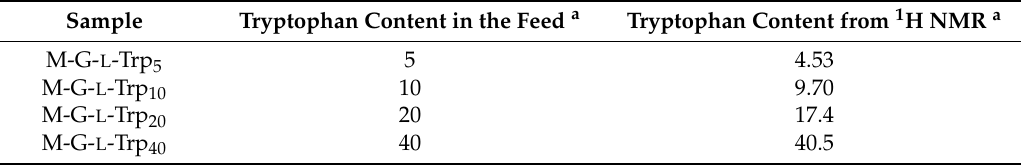
Figure 1. 1 H NMR spectrum of M-G- L -Trp 10 , recorded in D 2 O at 25 °C. Asterisks represent the signals of methylene and double bond protons of the terminal acrylamide. Table 1. Comparison of copolymers tryptophan content from reaction recipes and 1 H NMR.